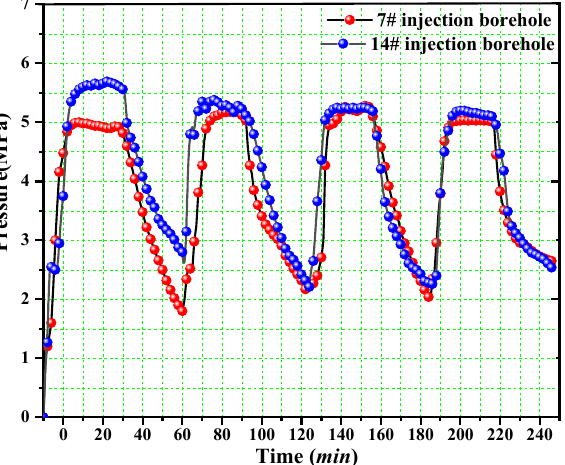
Figure 13. Variation in the pressure of the 7# and 14# injection boreholes.